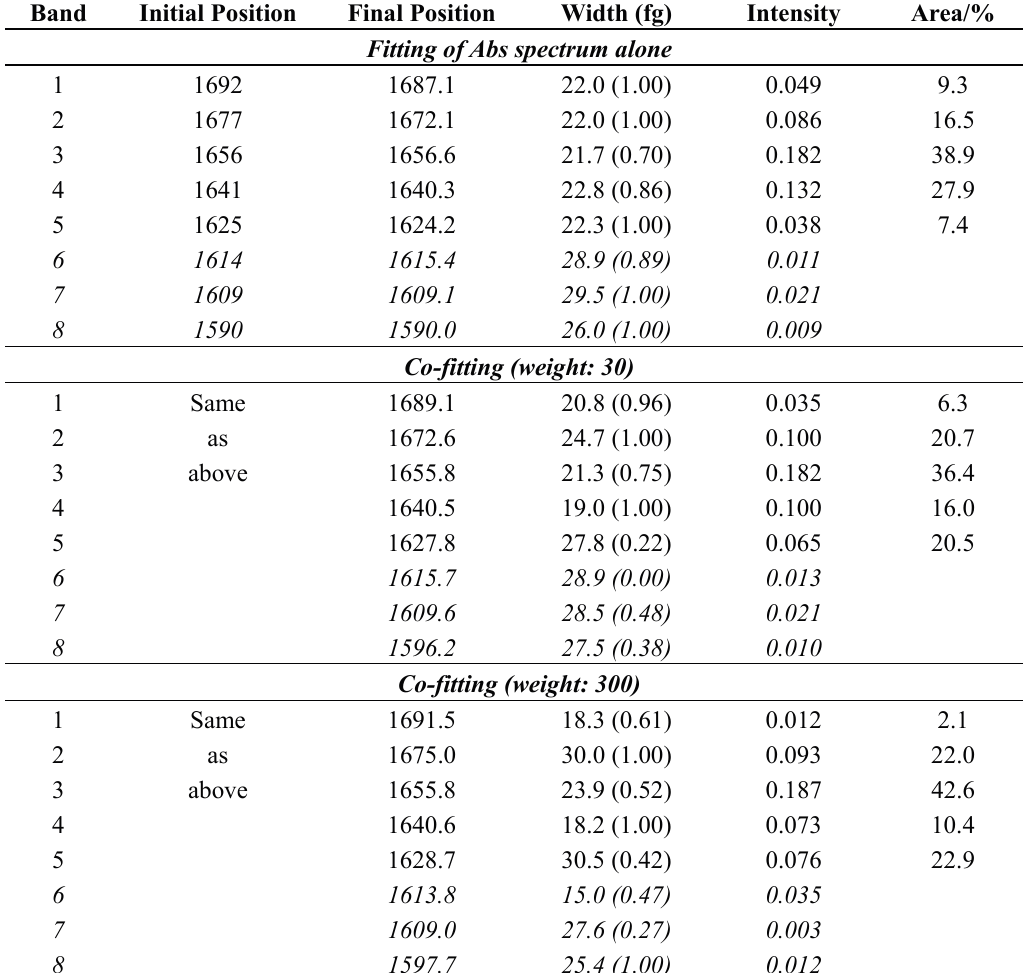
Table 4. Band parameters obtained upon standard fitting and co-fitting of aconitase. Values in italics correspond to amino acid side chain absorptions and where excluded from calculation of band area of the amide I band. The fg values denotes the fractional contribution of the Gaussian lineshape to the overall lineshape. The initial value was 0.50 for all